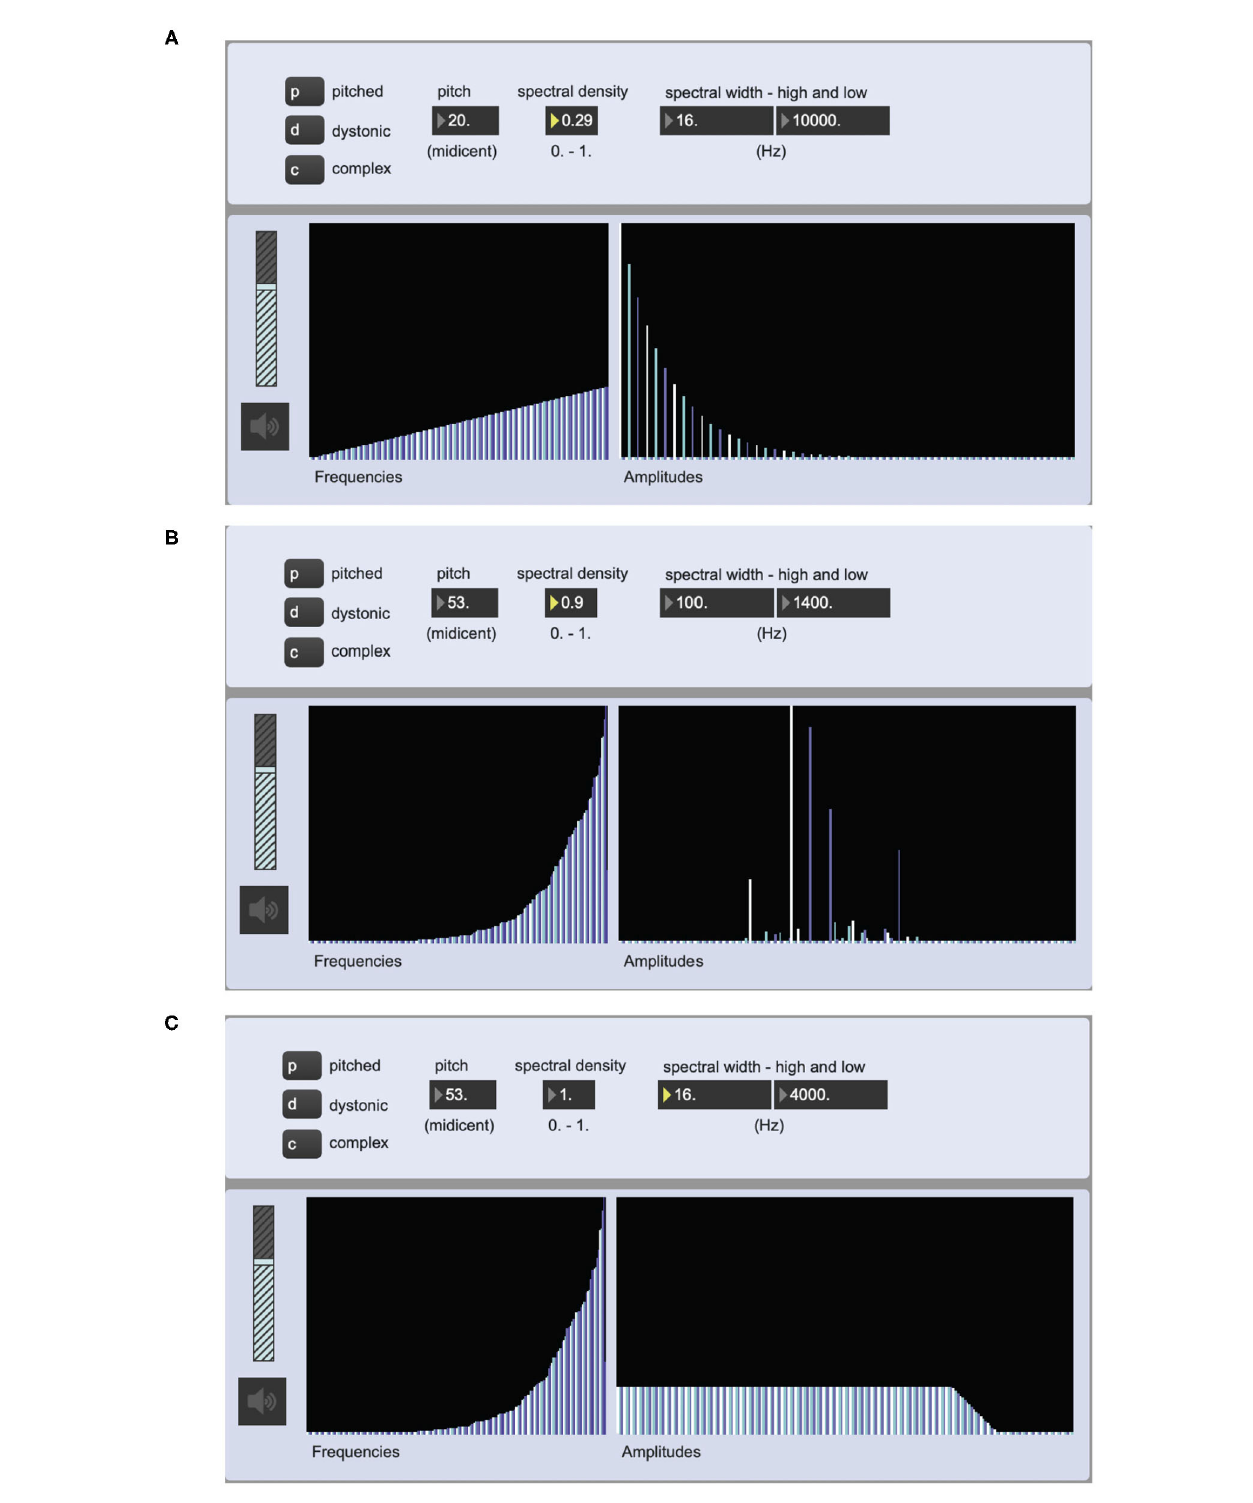
FIGURE 3 | Screen shot of a Max prototype for the implementation of the sonification of the notation data. The multisliders (interactive tables) show the partials of the oscillator bank along their X -axes and the corresponding frequency values (16 Hz-17 kHz) to the left and amplidudes to the right (0-1). The different colors of the bars are there to differentiate between adjacent partials. (A) is set to play a pitched sound object with a harmonic spectrum. (B) is set to play a dystonic sound object with an inharmonic spectrum, while (C) is set to play a complex sound object—in this case a noise.